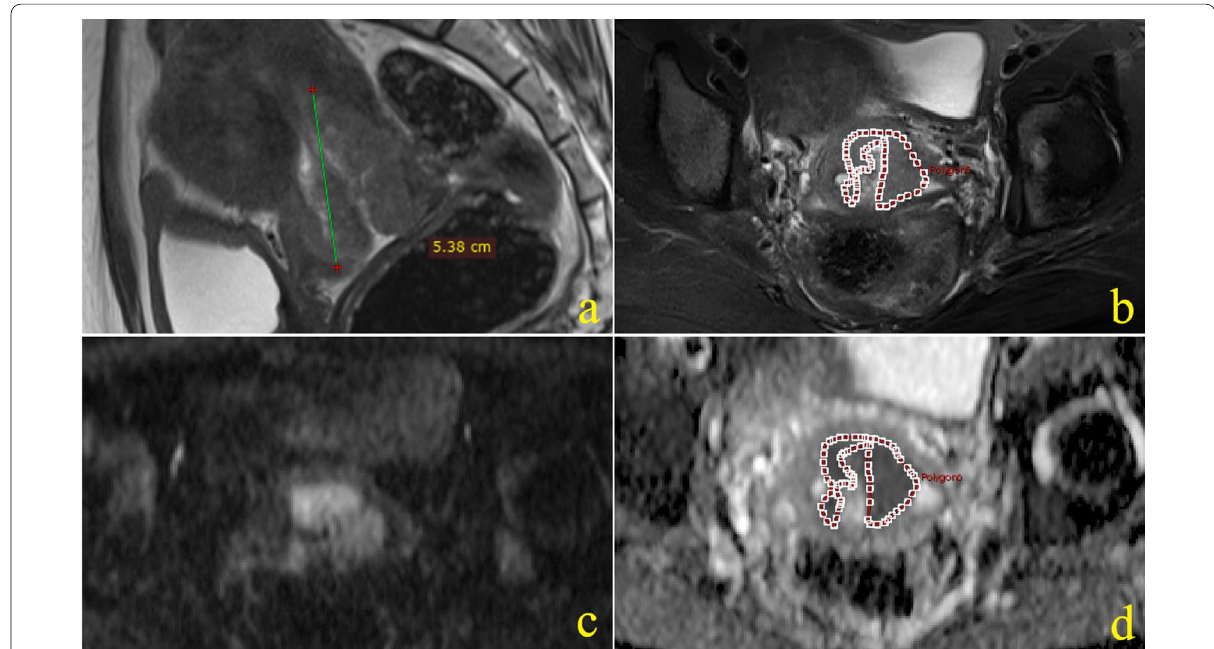
Fig. 2 Images of a 45-year-old cervical cancer patient, ( a ) sagittal T2-weighted image of the tumor, the maximum diameter of tumor showed at sagittal image was 53.8 mm; b – d showed manually drew ROI at the axial largest slice of the tumor on different sequences, ( b ) axial fat suppressed T2-weighted FSE sequence; c axial DWI ( b 1000 s/mm 2 ) sequence; d ROI of tumor on the corresponding slice of ADC map. FSE, fast spin-echo; = DWI, diffusion-weighted imaging; ADC, apparent diffusion coefficient; ROI, regions of